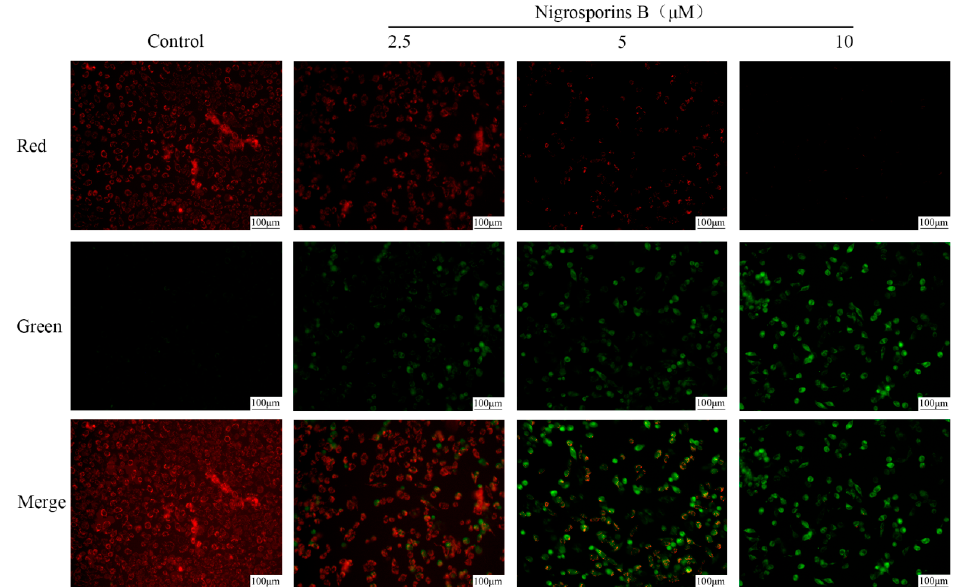
Figure 4. Using JC-1 fluorescence mitochondrial imaging assess the depolarization of MMP in Ca Ski cells, cells treated with Nigrosporins B (0, 2.5, 5, 10 µM) for 24 h. Scale bar: 100 µM. At high MMP, JC-1 exists as polymer emitted red fluorescence; at low MMP, JC-1 exists as a monomer and emitted green fluorescence.